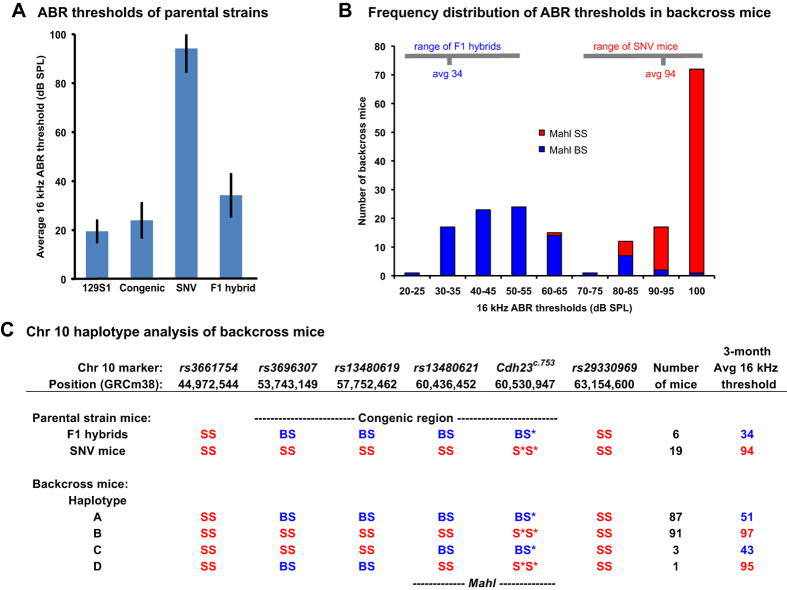
Localization of a hearing loss modifier in the 129S1.B6-Cdh23ahl congenic region.(A) Average 16 kHz ABR thresholds (±standard deviations) of 3-month-old 129 S1 inbred strain mice (N = 10), 129S1.B6-Cdh23ahlcongenic mice (Congenic; N = 10), 129S-Cdh23c.753A mice (SNV; N = 19), and (Congenic × SNV) F1 hybrids (N = 6). (B) Frequency distribution of 16 kHz ABR thresholds among 3-month-old N2 mice (N = 182) from a backcross of (129S-Cdh23c.753A SNV × 129S1.B6-Cdh23ahl congenic) F1 hybrids with 129S-Cdh23c.753A SNV mice. The threshold ranges and averages of age-matched parental strain mice (F1 hybrids, SNV mice) are indicated at the top of the figure as horizontal gray lines. N2 mice with homozygous and heterozygous Mahl genotypes are distinguished by red and blue colors. (C) Chr 10 haplotype analysis of N2 mice. SNP markers and their Mb positions along Chr 10 are shown above the corresponding genotypes of parental strain and N2 backcross mice. Haplotypes C and D contain crossovers within the congenic region, and the correlations of ABR thresholds with SNP genotypes further refine the candidate region of the modifier locus (designated Mahl). The 129S1.B6-Cdh23ahlcongenic region and the Mahl candidate gene region are indicated by dotted lines. The non-recombinant rs13480621 and Cdh23c.753A markers were used to assign Mahl genotypes in panel B above. Allele designations: B, C57BL/6-derived; S, 129S1-derived; S*, 129S1-derived with targeted Cdh23c.753G>A substitution.